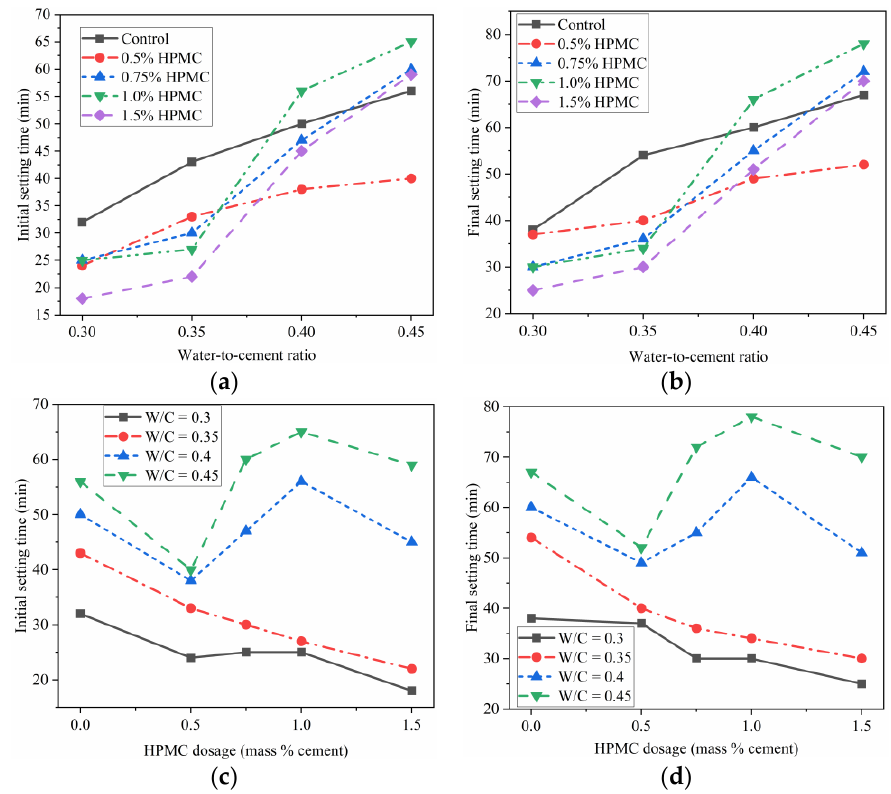
Figure 3. Setting time of the fresh mixed SAC paste with and without HPMC at different W/C: ( a ) initial setting time are plotted against W/C; ( b ) final setting time plotted against W/C; ( c ) initial setting time plotted against HPMC dosage; ( d ) final setting time plotted against HPMC dosage.